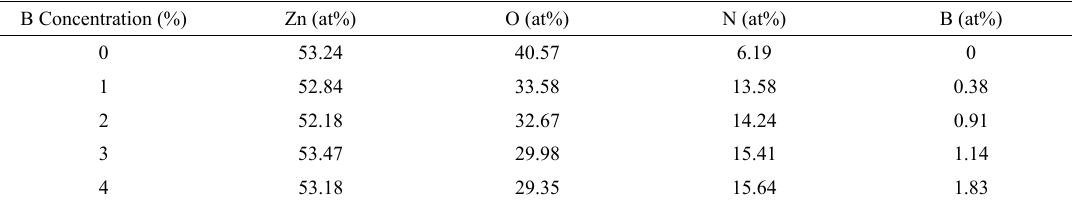
Table 2. Results of XPS